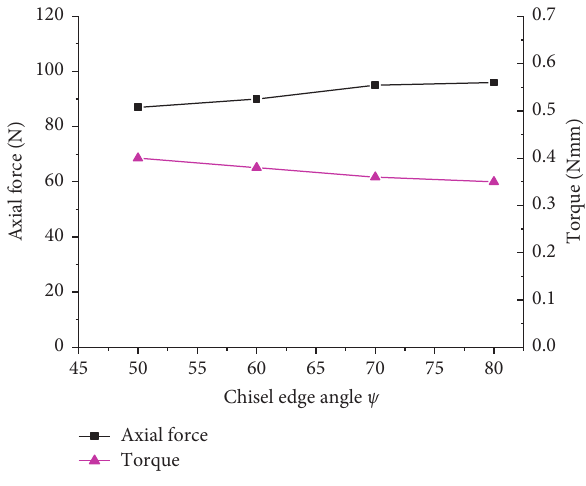
Figure 11: Drilling force at varying ψ .